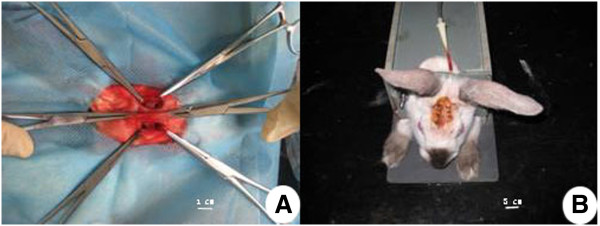
Preparation of animal model. (A) Preparation of skull defect. For each rabbit, two 3.5 mm holes were drilled on each side of skull, respectively. The two holes on one side of skull were used as control group, and the two holes on the other side of skull were used as experimental group in each rabbit. (B) Postoperative outline of negative vacuum tube. The vacuum tube was placed near two experimental holes. For each rabbit, −50 kPa of negative pressure was applied to two experimental holes for 15 min, which was performed 4 times per day.